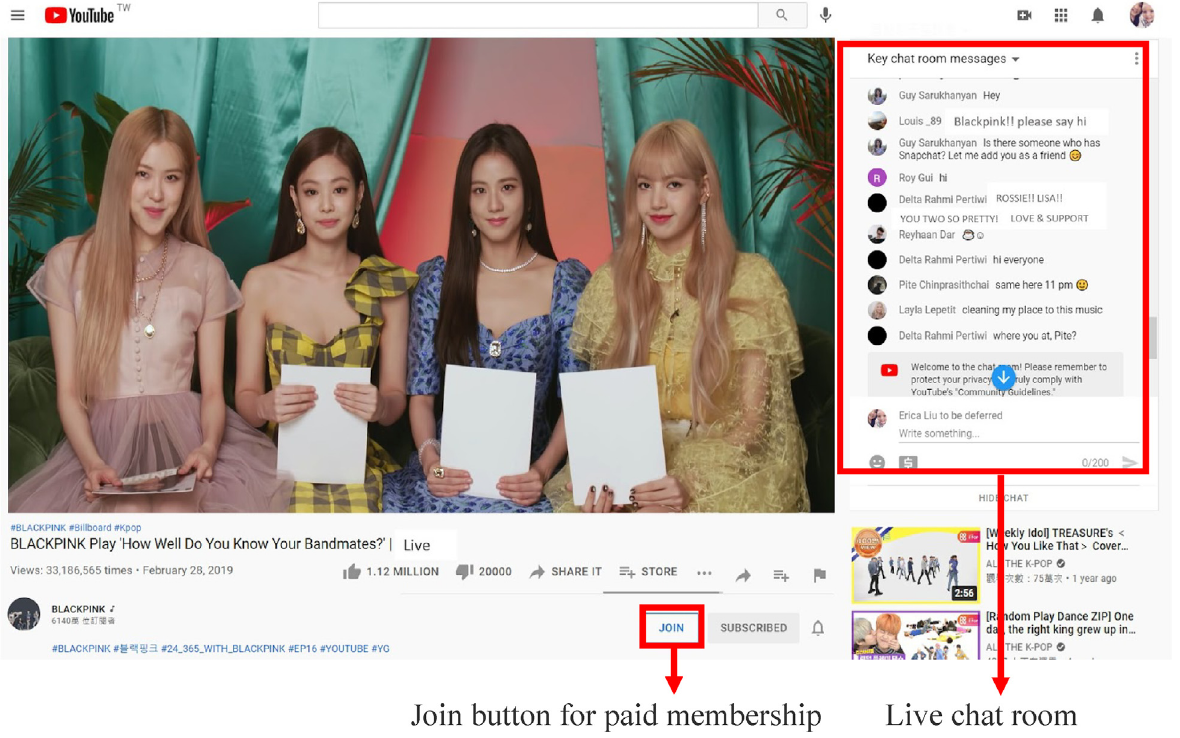
Figure A1. -A: An example of a KPOP group on YouTube Live.